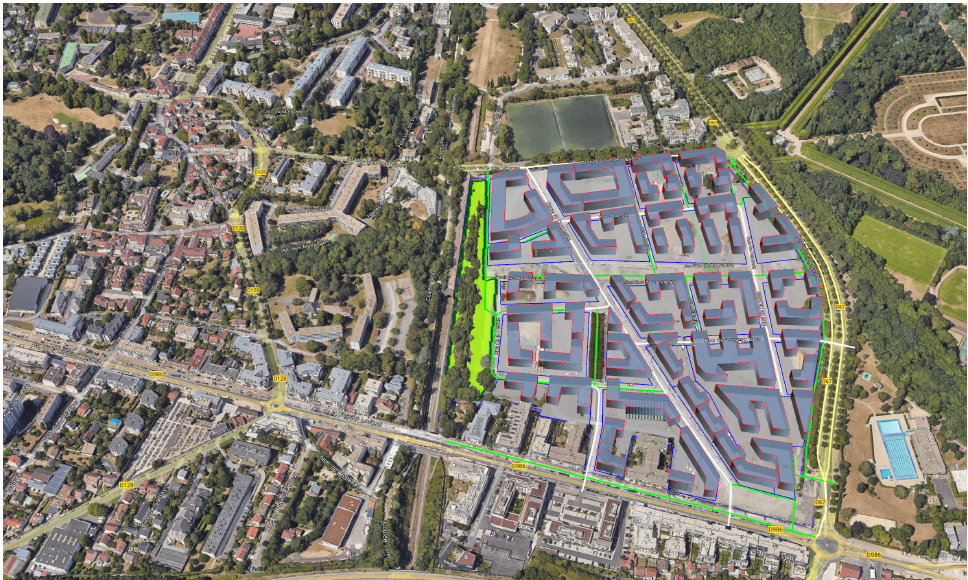
Figure 5. Mass plan of the future LaVallée neighborhood and its situation in the city. Aerial image: Google Earth